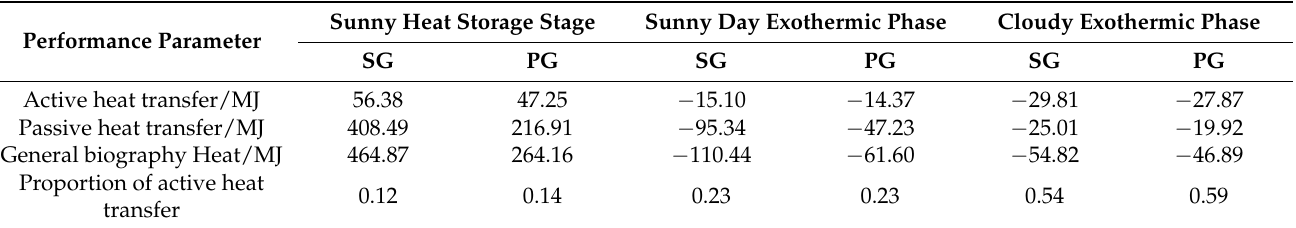
Table 1. Heat transfer characteristics of active heat storage in greenhouse and passive heat storage of the back